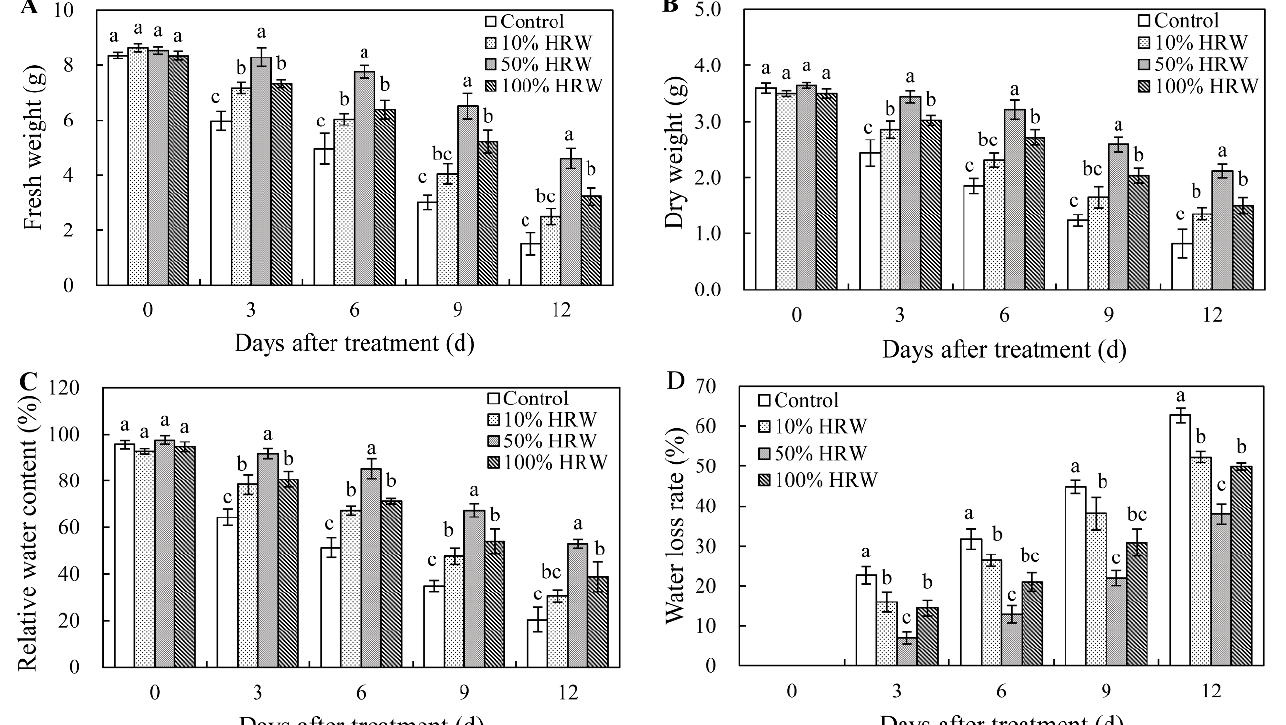
Figure 1. Effects of different concentrations of HRW treatments on fresh weight ( A ); dry weight ( B ), relative water content ( C ), and water loss rate ( D ) in Lanzhou lily scales during storage at room temperature for 12 days. Values are the mean ± SE of three independent experiments. Variance analysis was performed according to Tukey’s multiple range test. Different lowercase letters indicate the significant difference under different treatments on the same day ( p < 0.05). HRW: hydrogen-rich water.